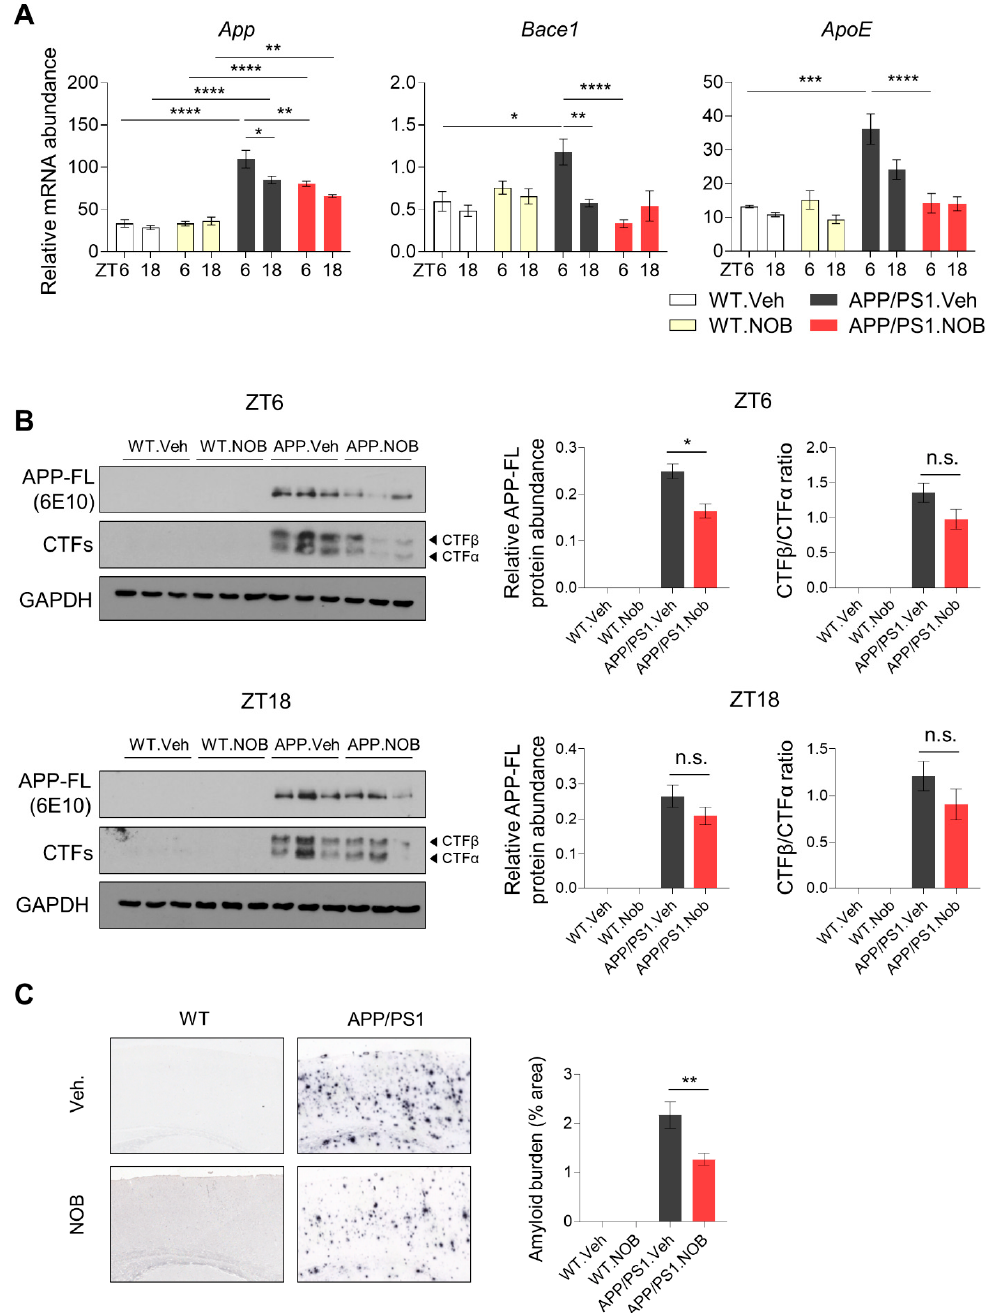
Figure 5. NOB modulates AD gene expression and ameliorates A β deposits in APP/PS1 mice. ( A ) mRNA expression of AD-related genes in WT and APP/PS1 mice. mRNA expressions of core clock genes in cortex tissues were measured by using real-time qPCR (n ≥ 3/each group). Mice were sacrificed at ZT6 and ZT18 under the LD condition. Data represented by mean ± SEM in bar graph. * p < 0.05, ** p < 0.01, *** p < 0.001, and **** p < 0.0001. ( B ) Protein levels of APP-FL and CTFs were detected by using human 6E10 and carboxyl-terminal fragments (CTFs)-specific antibodies in cortex lysates at ZT6 and ZT18. GAPDH served as the loading control. Left panels: representative blot images. See Figure S4B for the whole blot images and size markers. Right panels: quantification of APP-FL and CTFs (n = 3/group). Data represented by mean ± SEM. * p < 0.05, unpaired Student’s t -test. ( C ) Immunohistochemistry of A β in APP/PS1 mice using the 4G8 antibody in the cortex (n = 6–11). Right panels: Quantification of amyloid burden (4–6 slices/mouse). Data represented by mean ± SEM. One-way ANOVA with Tukey’s multiple comparison test shows significant statistical difference between APP/PS1.Veh and APP/PS1.NOB (**, p <